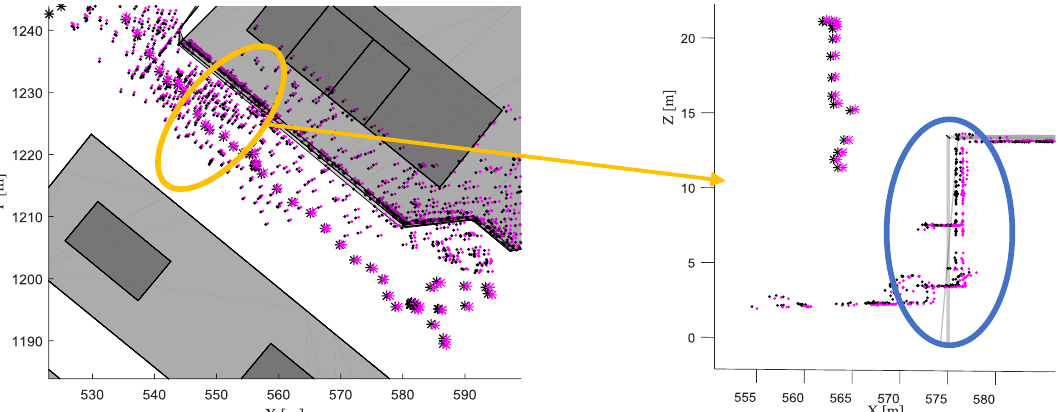
Figure 5: Detail of the results of hybrid adjustment with real data after including images with GNSS and planes (step 4). Black dots: estimated tie points; black asterisks: estimated camera positions; magenta dots/asterisks: initial tie point and camera positions from step 2, respectively. The right part of the figure shows a cross-section through the area highlighted by an orange ellipse in the left part of the figure (see main text for a discussion).